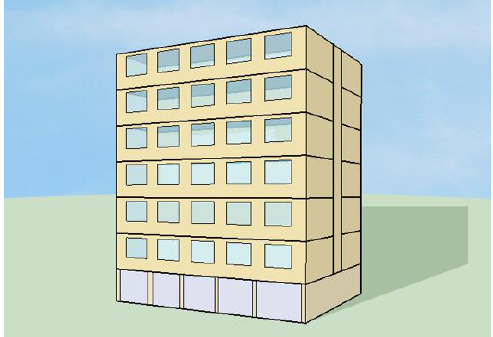
Figure 2. Multi-apartment building adopted from [18].